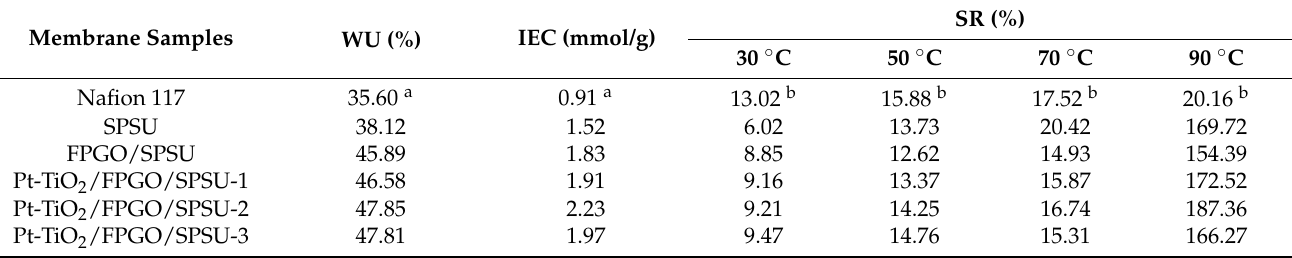
Table 3. WU, IEC and SR of all the membranes.